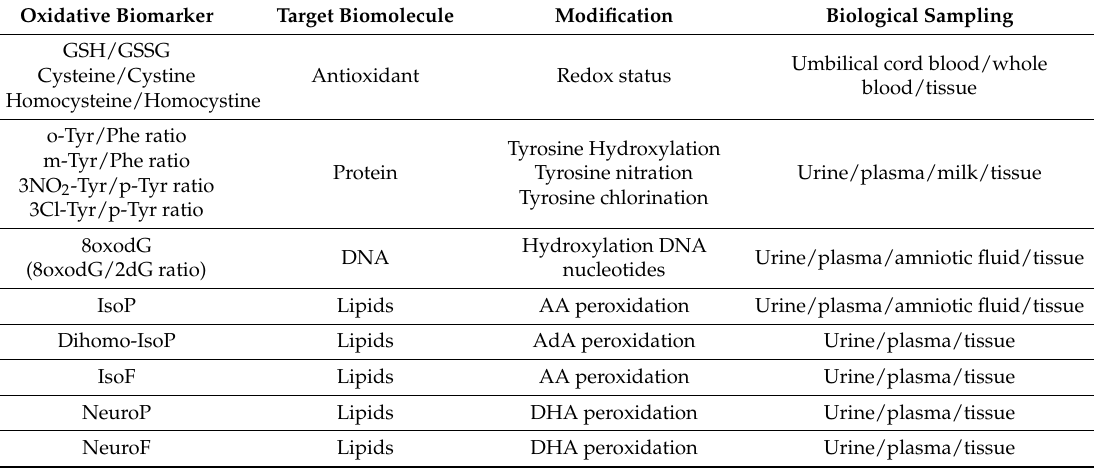
Table 1. Summary of the most relevant biomarkers used in neonatal clinical research.